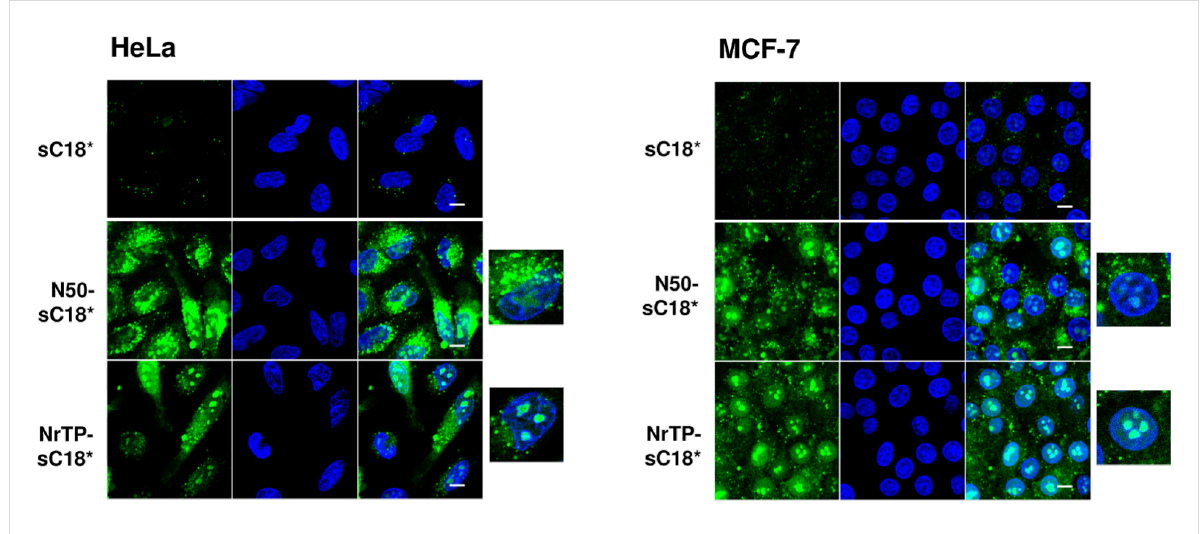
Figure 3: Cellular uptake in HeLa and MCF-7 cells. Cells were incubated for 30 min with 10 µM of CF-labeled peptide solutions. Green: CF-labeled peptide; blue: Hoechst 33342 nuclear stain; scale bar is 10 µm.